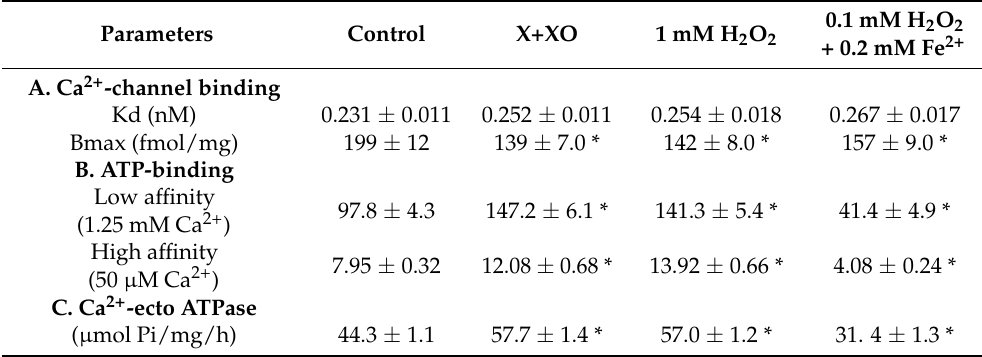
Table 3. Modification of Ca 2+ -channels, ATP receptors, Ca 2+ -binding and Ca 2+ -ecto ATPase in cardiac sarcolemma upon incubation for 30 min with oxyradical generating